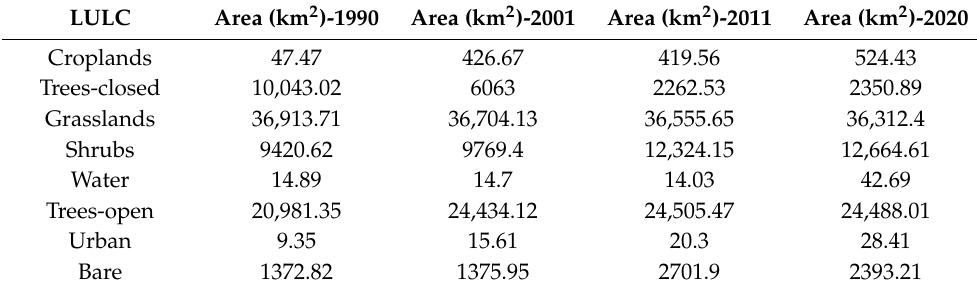
Figure 7. LULC change magnitudes shown as a percentage from 1990 to 2020 for the Northern Kenya/Southern Ethiopia study region. Table 5. Land cover distribution in km 2 for the years 1990 to 2020 for the Northern Kenya/Southern Ethiopia study region.